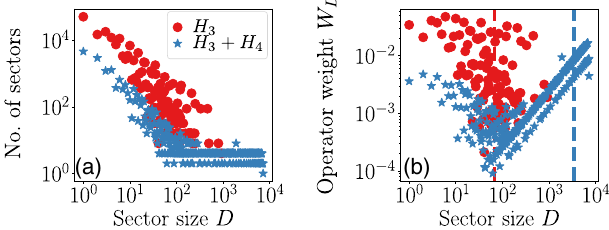
FIG. 5. Comparison of the Hilbert space connectivity. (a) Sector size distribution for H 3 (red dots) and H 3 þ H 4 (blue stars). (b) The operator weight W D distribution for S z 0 is qualitatively different, dominated by large sectors in the latter